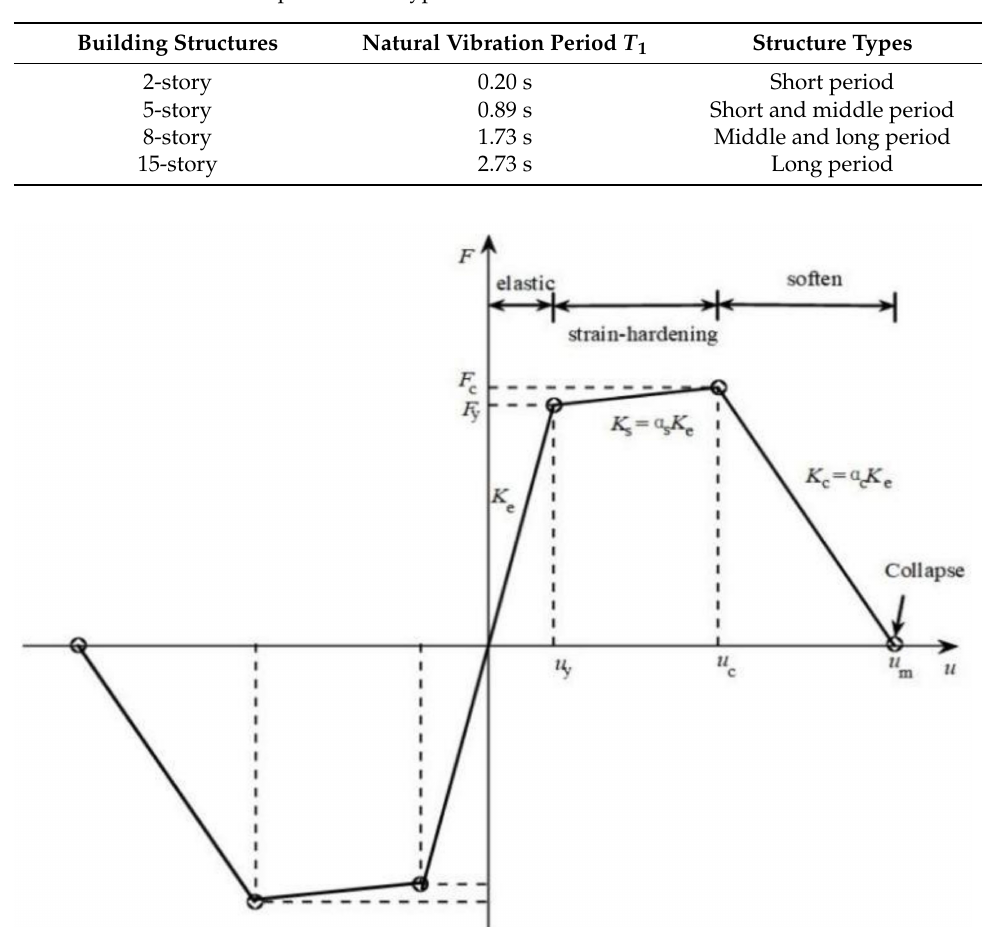
Table 2. Natural vibration periods and types of structures.